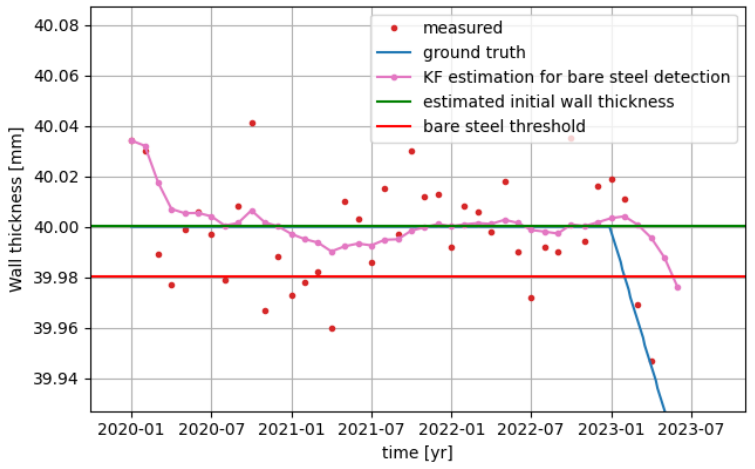
Figure 2. Output of the corrosion detection algorithm on simulated measurement data of a single position, along with the ground truth for reference. Again, a Gaussian measurement noise with a standard deviation of 20 µ m is used here.